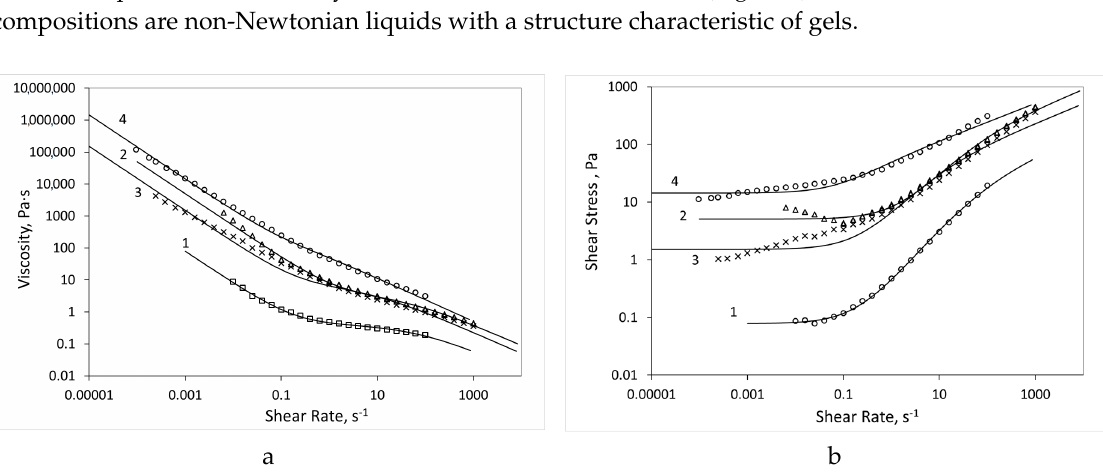
Figure 3. Micrographs (100×) of thin sections of freeze-dried hydrogels ( a ) ALG, ( b ) ALG-CNW (7.5%).